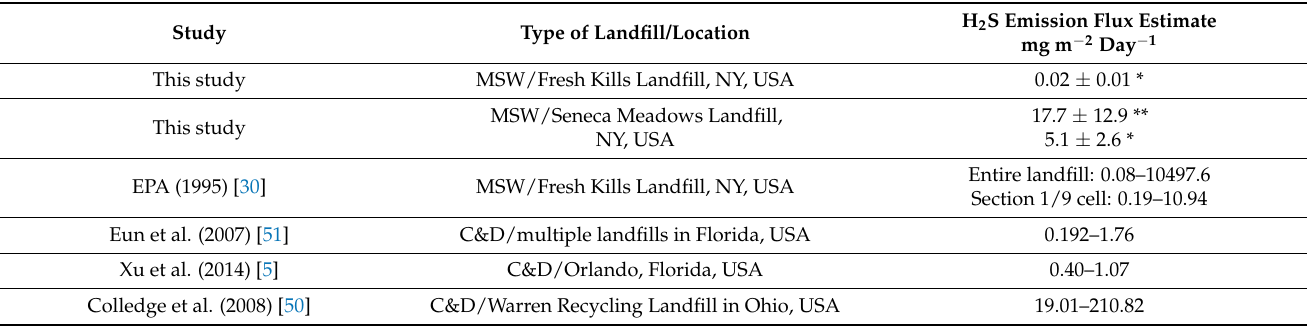
Table 1. H 2 S emission flux estimates from this study compared to previous work.